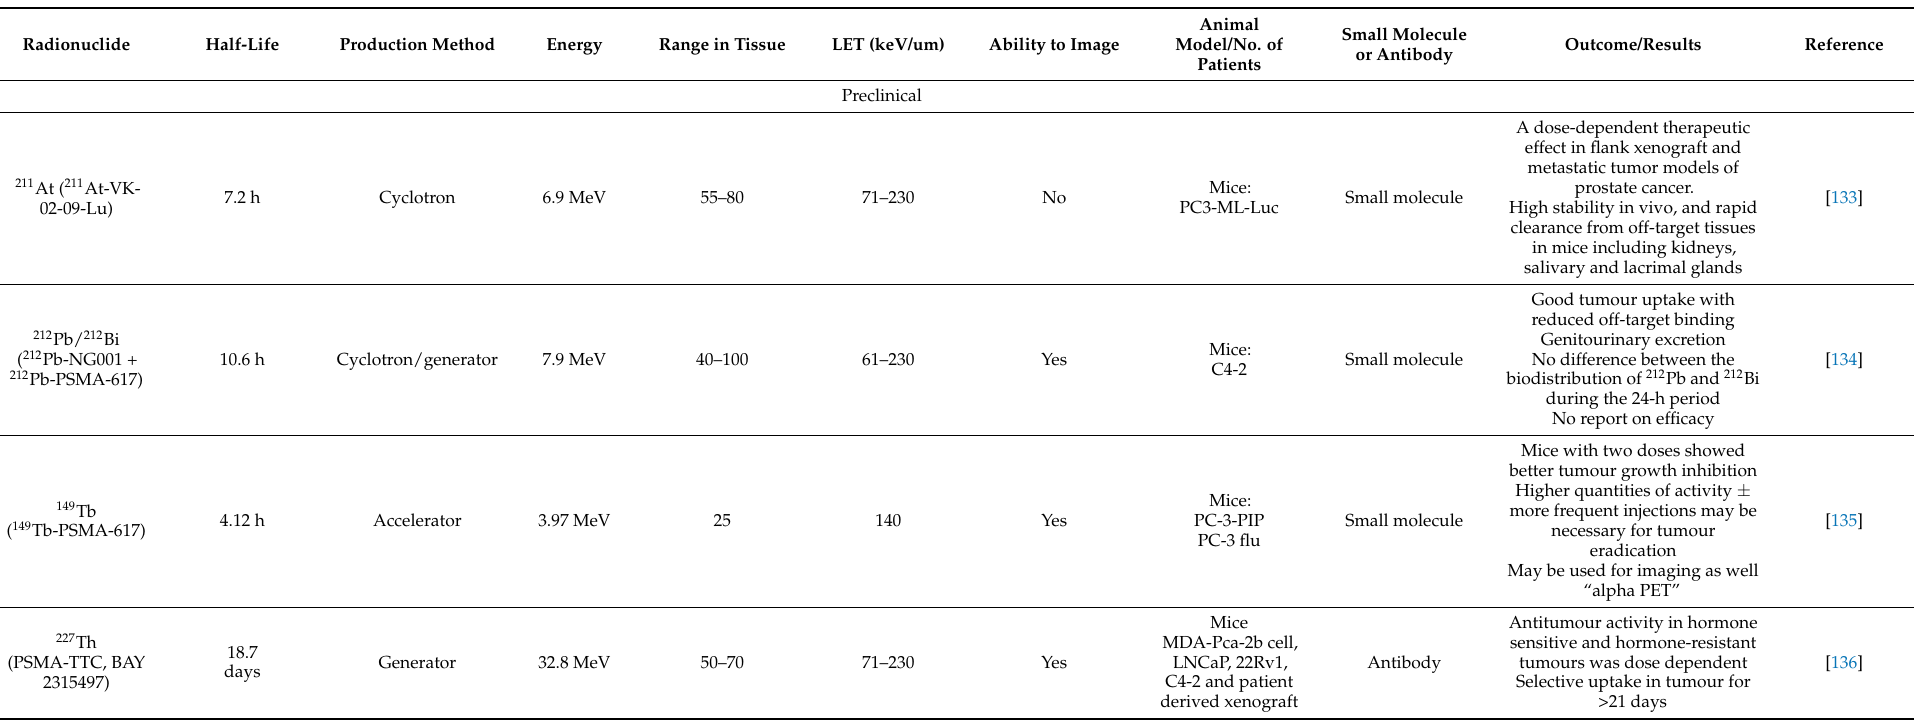
Table 1. An overview of alpha emitting radionuclides under both investigation clinical use for targeted alpha therapy for mCRPC